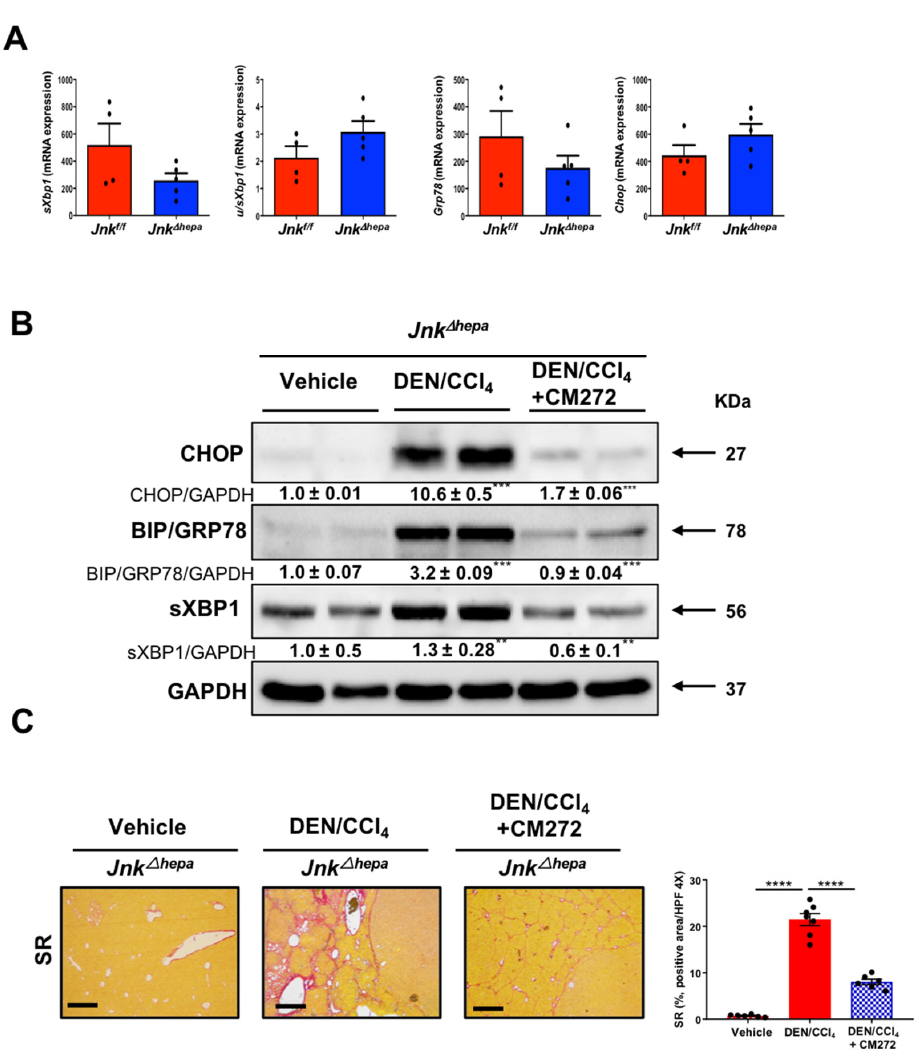
Figure 9. DEN/CCl 4 challenge in Jnk Δ hepa mice results in the activation of the unfolded protein response (UPR), cystogenesis and fibrosis in the liver: inhibitory effect of targeting the epigenetic G9a/DNMT1 complex. ( A ) mRNA expression levels of sXbp1 , uXbp1 , Bip/Grp78 and Chop evaluated by qRT-PCR in the livers of 22-week-old Jnk fl/fl and Jnk Δ hepa mice. ( B ) Expression of CHOP, BIP/GRP78 and sXBP1 proteins as assessed by Western blot in Jnk Δ hepa control mice (Vehicle), DEN/CCl 4 -challenged mice and DEN/CCl 4 -challenged mice treated with the G9a/DNMT1 inhibitor CM272. Numbers denote the molecular weight (KDa) of proteins. GAPDH served as loading control. Representative images are shown. Bands were quantitated and Vehicle vs. DEN/CCl 4 samples, and DEN/CCl4 vs. DEN/CCl 4 + CM272 groups were respectively compared. ( C ) Fibrosis was evaluated by Sirius Red (SR) staining in Jnk ∆ hepa mice treated as indicated. Scale bars, 500 µ m. Quantification of SR areas using ImageJ was performed. Data are represented as the mean ± SEM ( n = 5–7 mice per group, ** p < 0.01; *** p < 0.00,**** p <